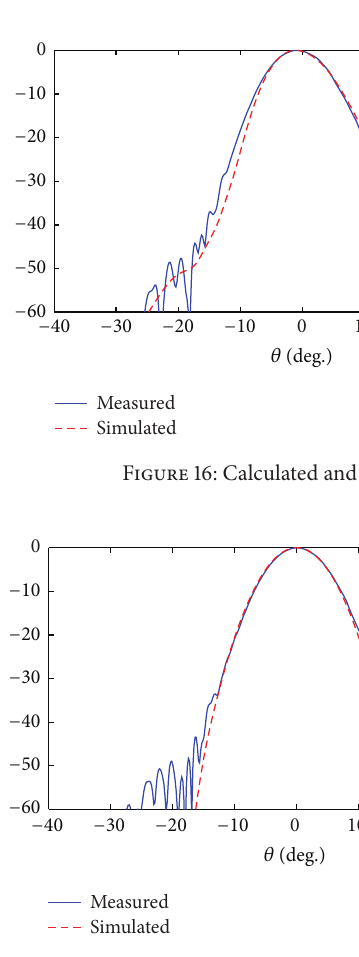
Figure 17: Calculated and simulated far field patterns of the 325 GHz channel on vertical